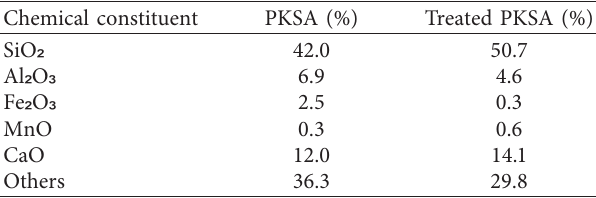
Table 1: Chemical composition of PKSA and leached PKSA. Chemical constituent